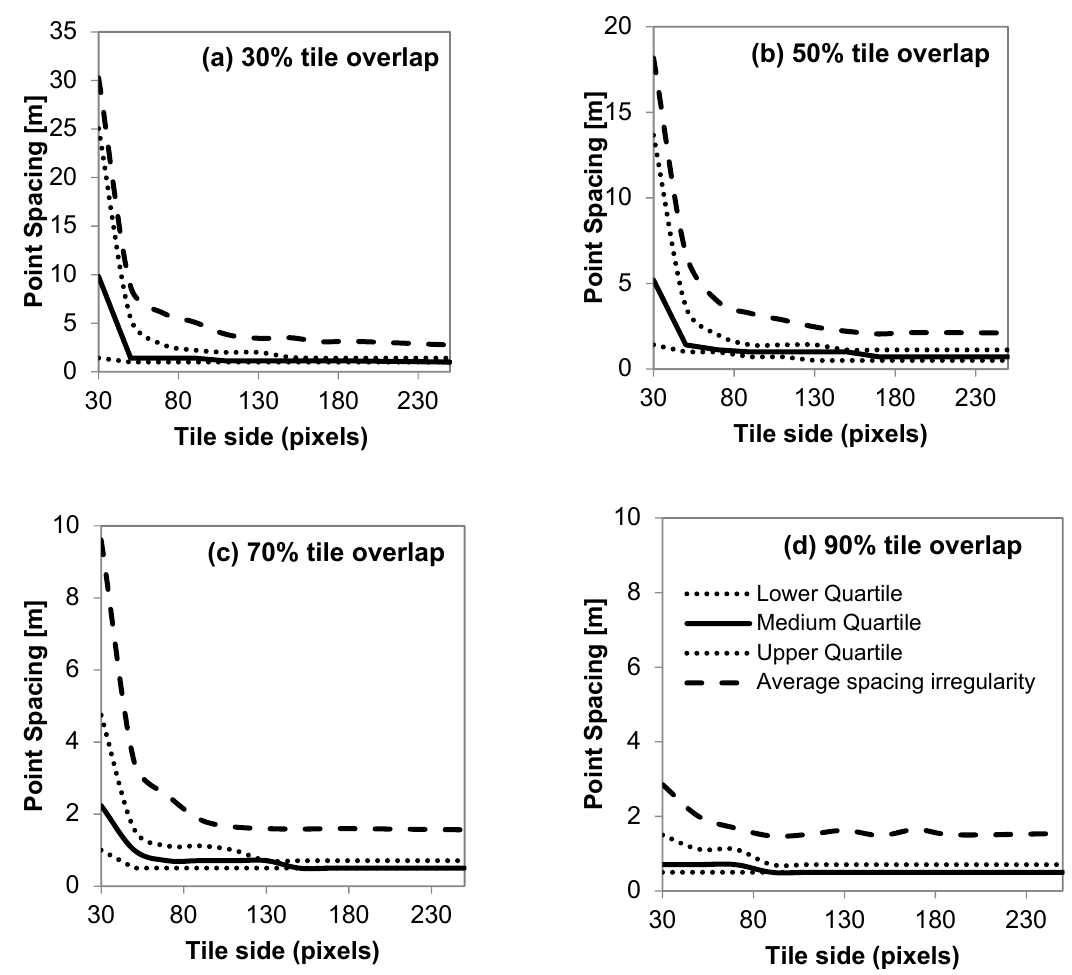
Figure 7. Resulting first, second, and third quartiles and average spacing irregularity of point matches from cascading of rectangular tiles with side 𝑝 ranging from 30 to 250 pixels and overlap of 30% to 90%.